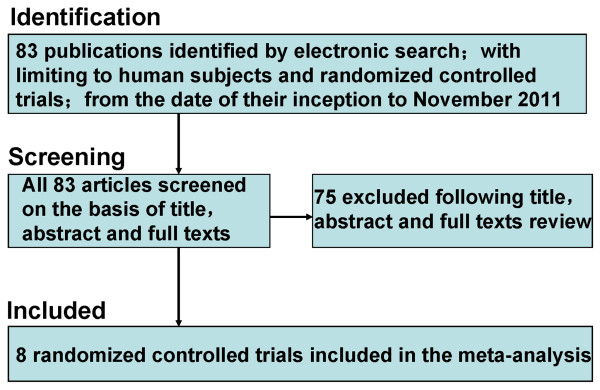
Search strategy.